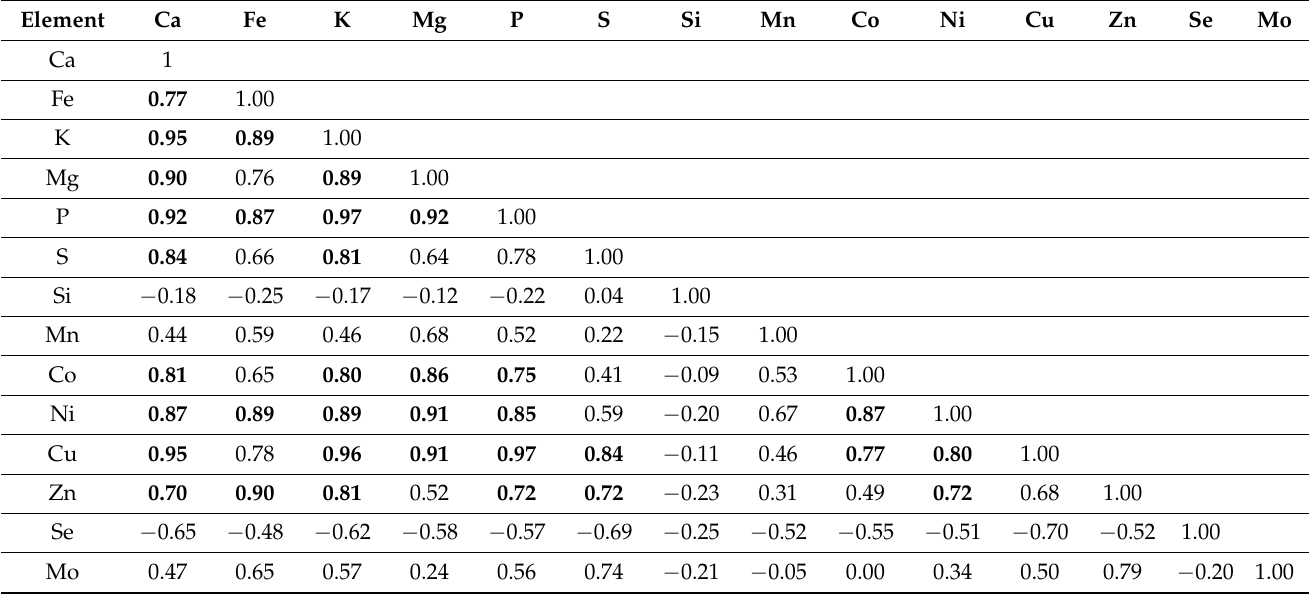
Table 9. Correlations between essential and beneficial elements.